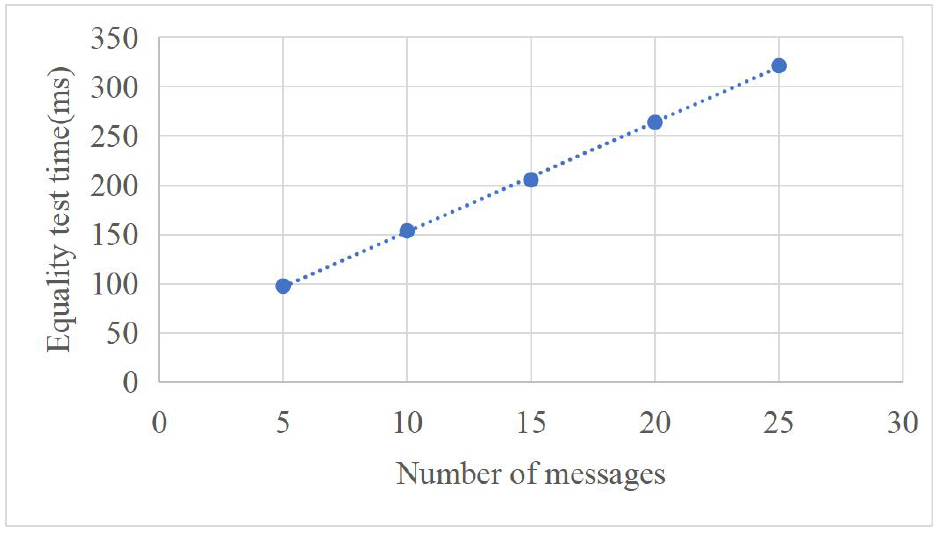
Figure 5. Test time according to